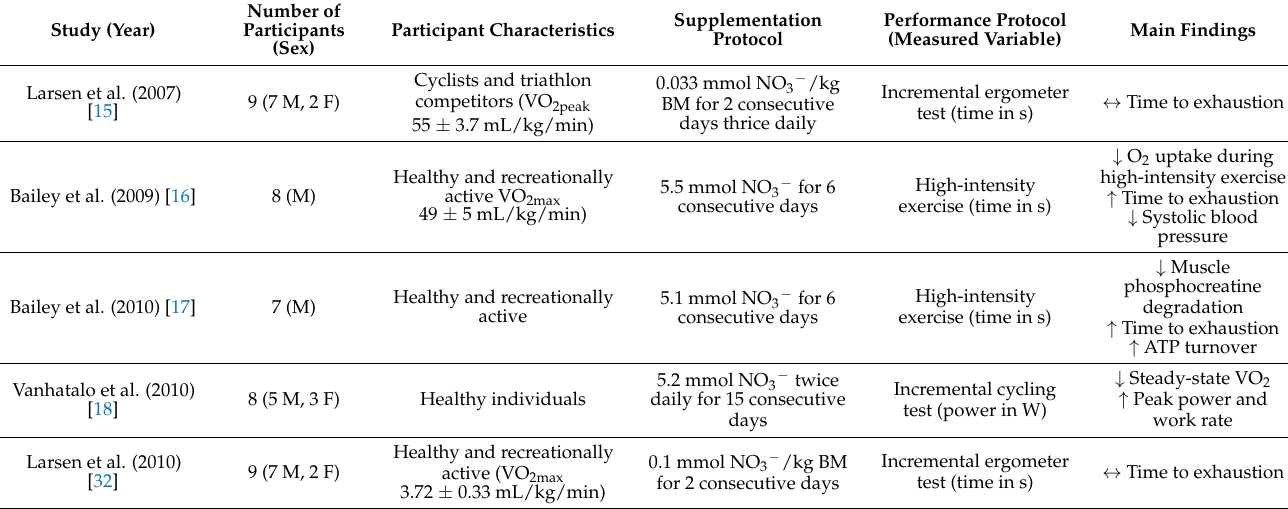
Table 1. Effects of nitrate supplementation on exercise